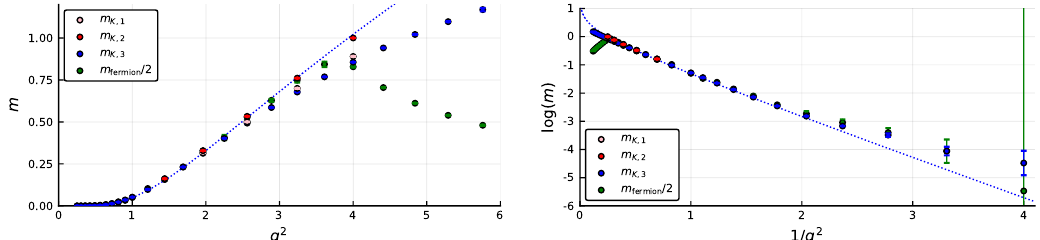
Figure 2 . Extrapolated mass scales and a fit to small couplings, presented in two different ways. The linear behaviour in the second panel follows from the leading order contribution in log( m K ) . The error bars correspond to the uncertainty in the δ → 0 extrapolations. Fits are made against the inverse correlation length ( m K, 3 ) data and take the form log( m K, 3 ) = log( C Λ lat ) and C is consistent with the value predicted by the field theory results up to 4%